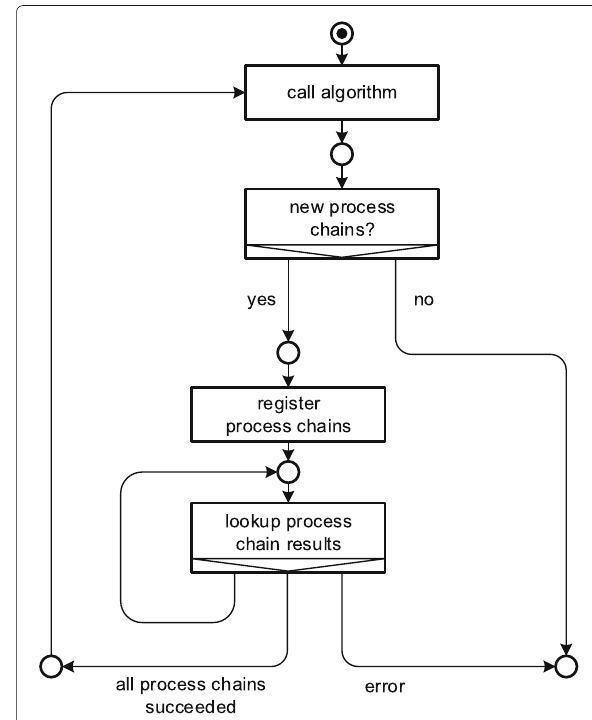
Fig. 12 The control flow in the Controller during workflow execution